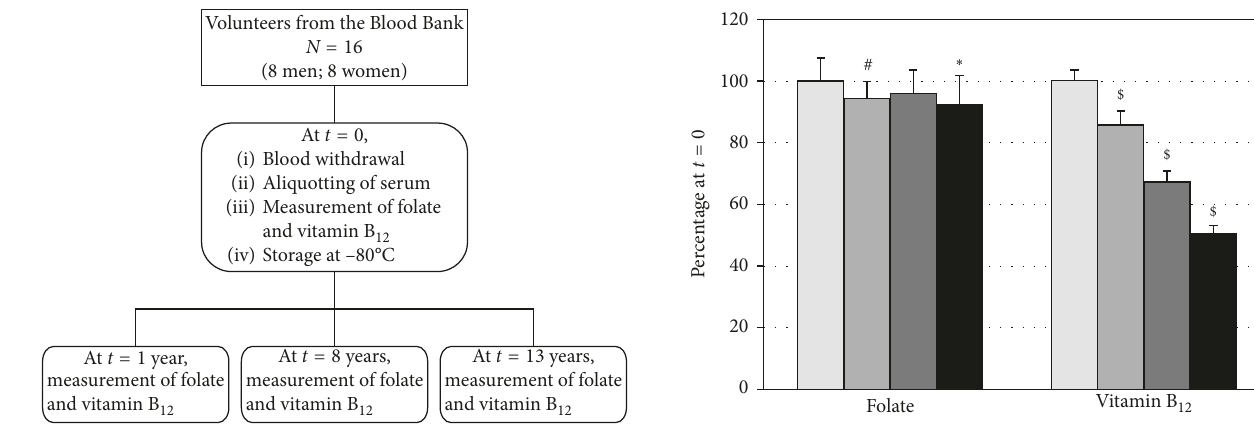
Figure 1: Flow diagram of the study.